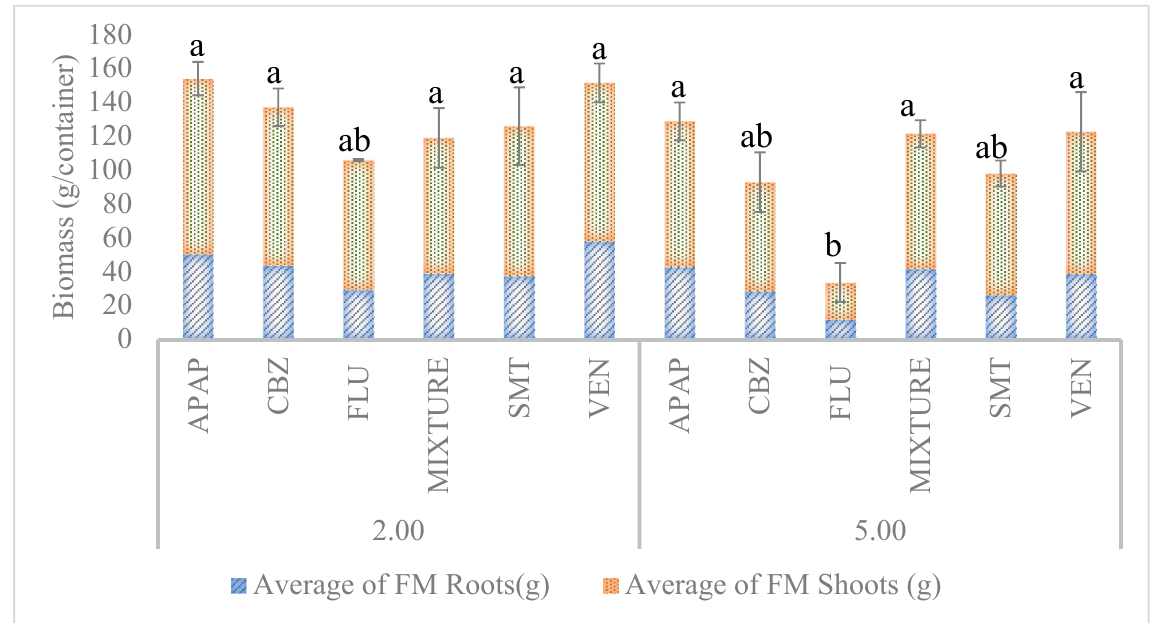
Figure 3. Influence of xenobiotics on the total fresh mass in Tripolium pannonicum (FM = fresh mass; APAP = acetaminophen; CBZ = carbamazepine; FLU = fluoxetine; MIXTURE = mixture of all five xenobiotics; SMT = sulfamethazine; VEN = venlafaxine; 2 = 2 mg L − 1 ; 5 = 5 mg L − 1 . Columns show average ± standard error of three biological replicates per treatment. Values with the same letter are not significantly different ( p > 0.05)).